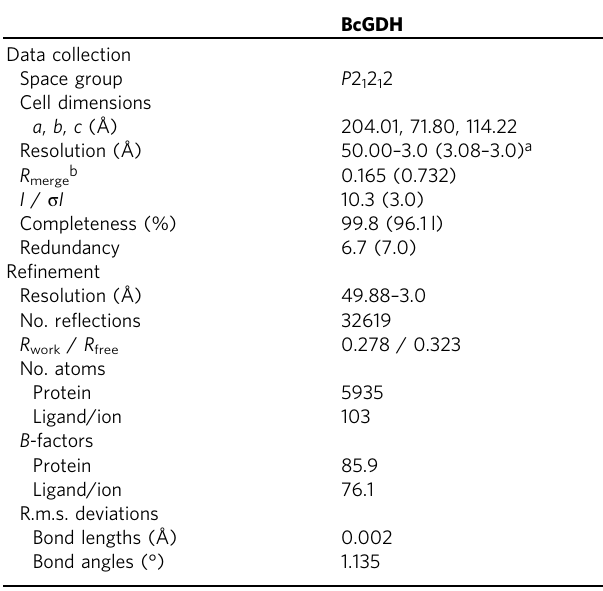
Table 5 Data collection and re fi nement statistics (molecular